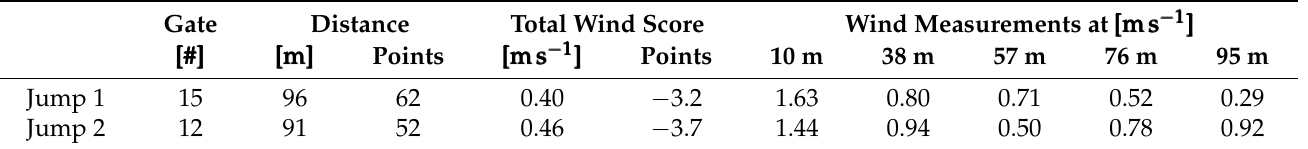
Table 3. External data for the two jumps chosen for the case study. Distance points and wind points showing the length and wind compensation points in an FIS